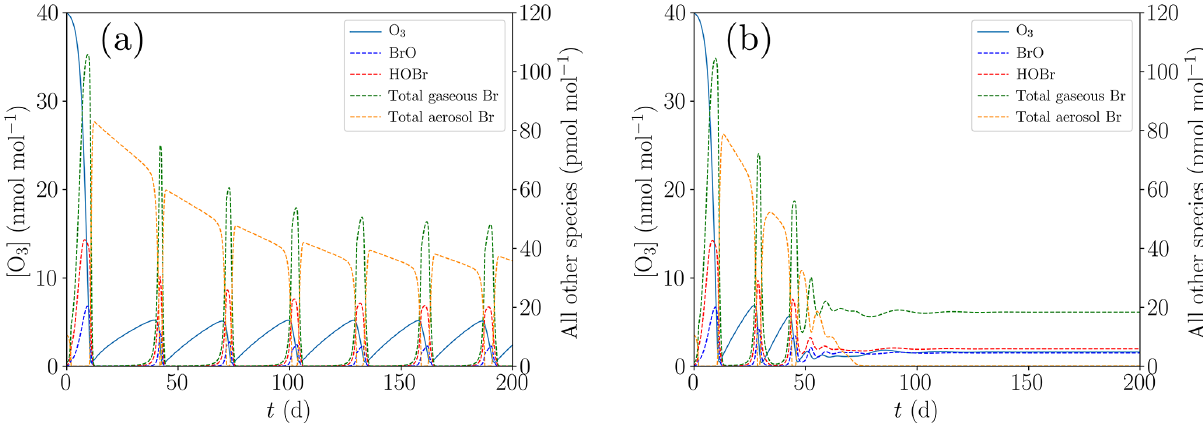
Figure 6. Oscillation and termination of ODEs for different values of k t , inv . (a) k t , inv = 10cm 2 s − 1 , (b) k t , inv = 20cm 2 s − 1 .